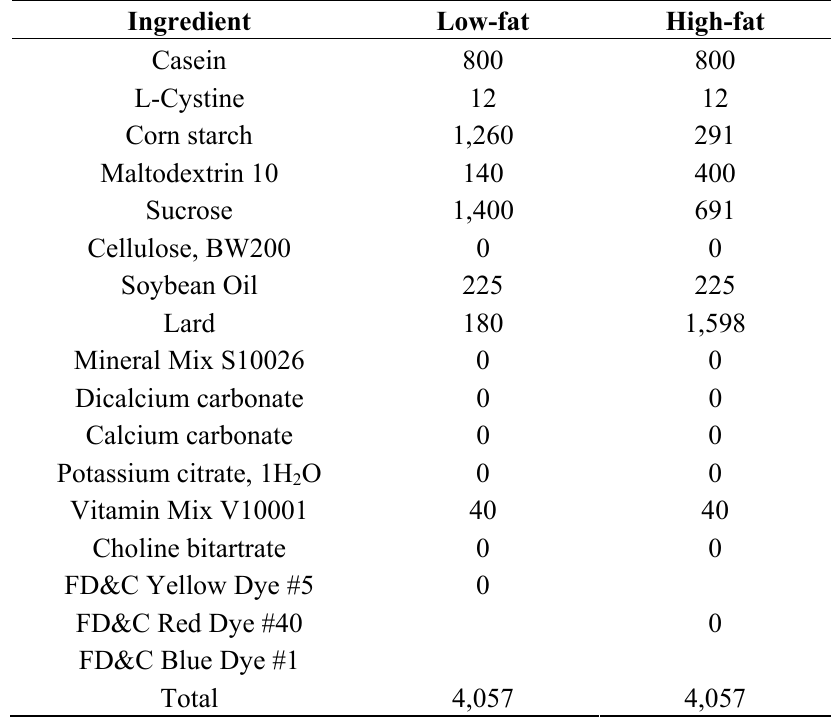
Table 3. Composition of the high- and low- fat diets